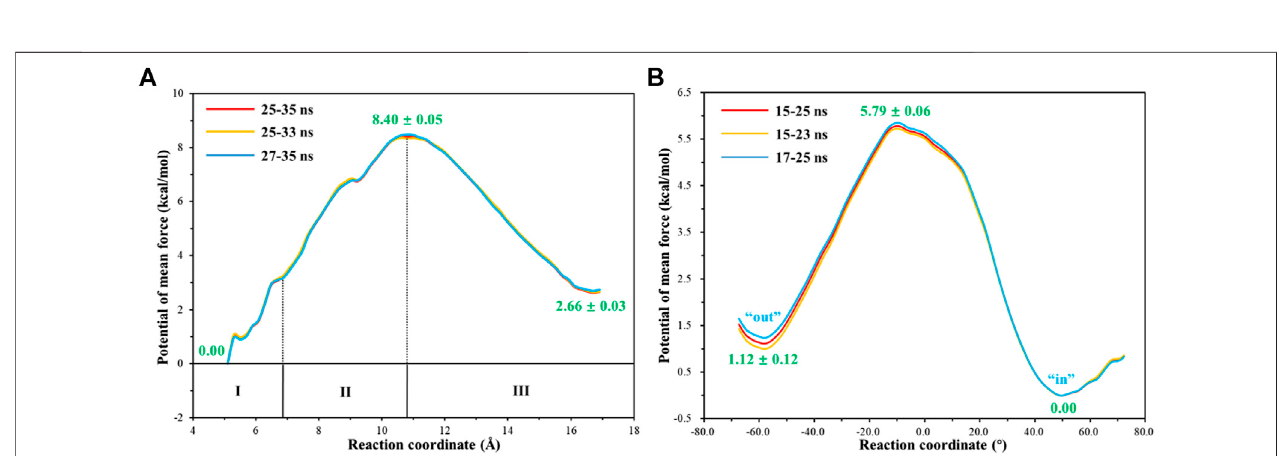
FIGURE 12 | (A) Free energy pro fi le for the release of HCO 3- from the active site to the bulk water. (B) Free energy pro fi le for the rotation of the unprotonated H64 from outward to inward conformation.